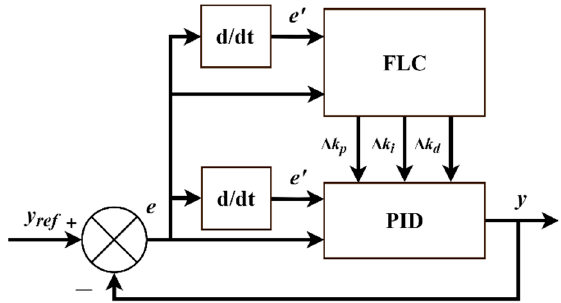
Figure 2. Block diagram of Fuzzy-PID control strategy system.